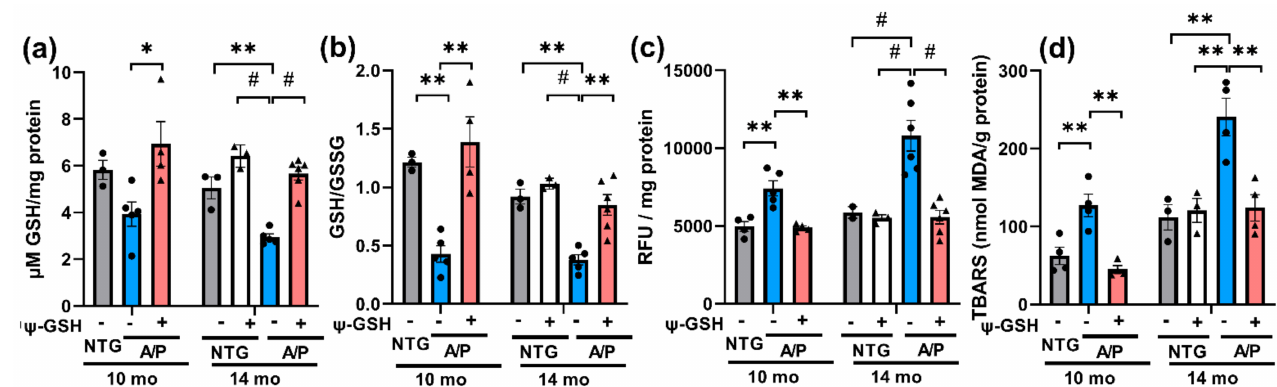
Figure 2. ψ -GSH treatment reverses oxidative stress in the APP/PS1 model. ( a ) ψ -GSH treatment restored the levels of reduced GSH to NTG controls. ( b ) Attenuation of oxidative stress was evident from enhanced redox potential in mice after ψ -GSH treatment in both symptomatic cohorts. ( c ) Total oxidative stress as measured by DCFH-DA assay was also mitigated by ψ -GSH in these mice irrespective of age. ( d ) TBARS results are shown as the mean ± S.E.M. Statistical significance was assessed by a one-way ANOVA with Tukey’s post-hoc test. * p < 0.05, ** p < 0.01, # p <